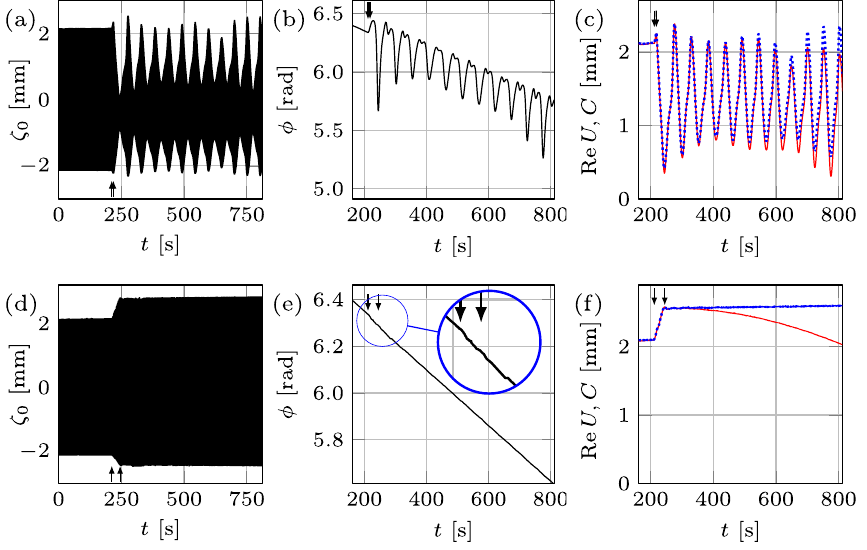
Figure 4. Wall speed effect at f = 12.33 Hz and A = 1.26m s − 2 . The slower evolution of the domain prevents the system from entering the chaotic regime. The domain shrinkage (cid:31) L = 2 mm starts at L = 122 mm with two wall speeds 0.15 (top) and 0.03mm s − 1